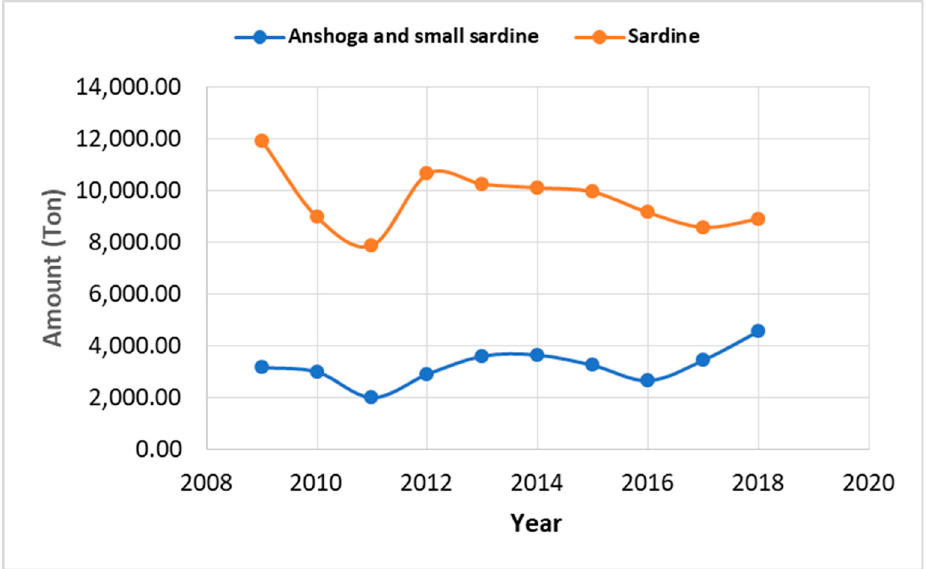
Figure 11. The annual amount of sardine catches (Ton) in Egypt Mediterranean water from 2009 to 2019 (Source: GAFRD 2019).